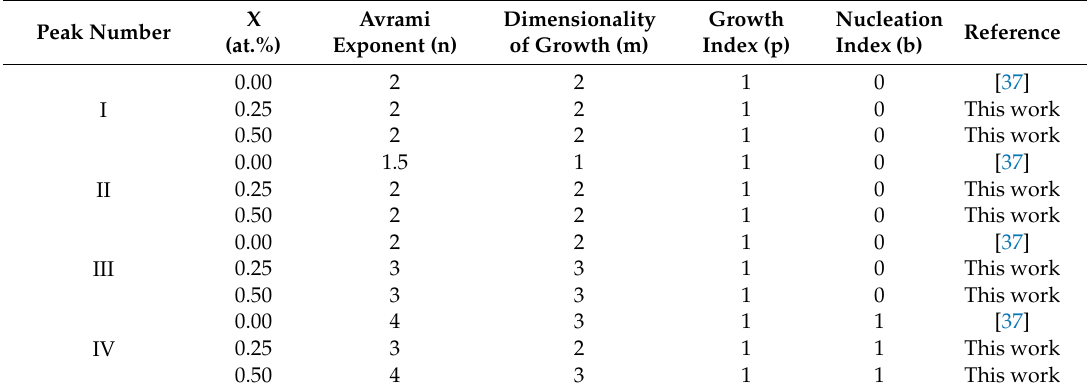
Table 3. Nonisothermal crystallization kinetics data for nucleation and growth